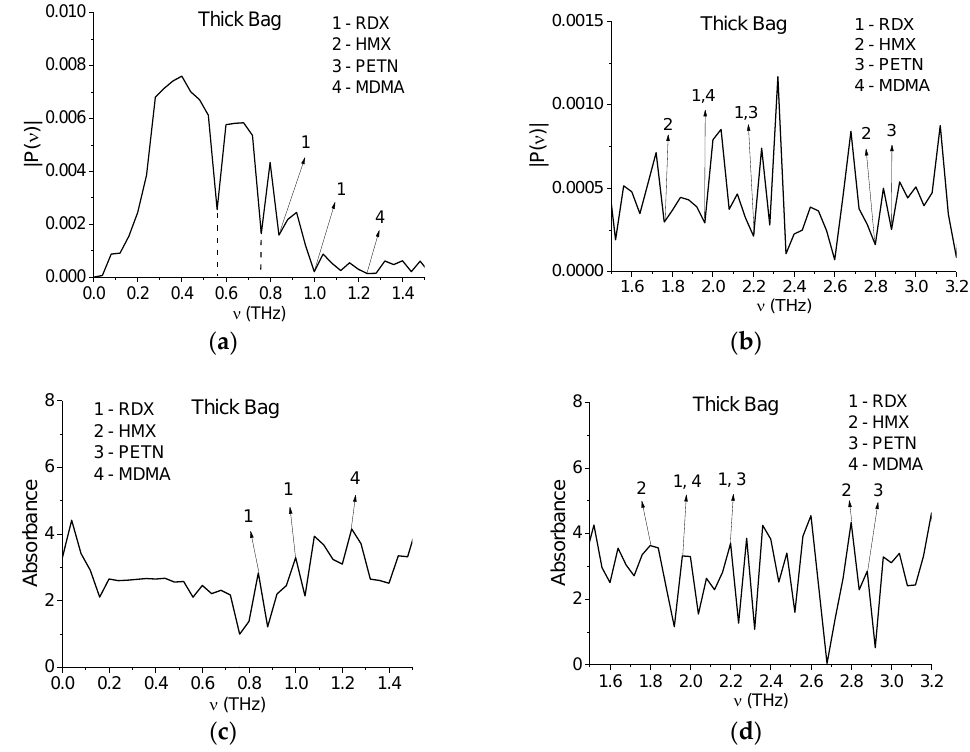
Figure 3. Fourier spectrum of the main pulse of the Thick Bag signal ( a , b ) and the absorbance of the sample ( c , d ) in the frequency ranges ν = [0, 1.5] THz ( a , c ); ν = [1.5, 3.2] THz ( b , d ) calculated with frequency resolution Δν = 0.04 THz.